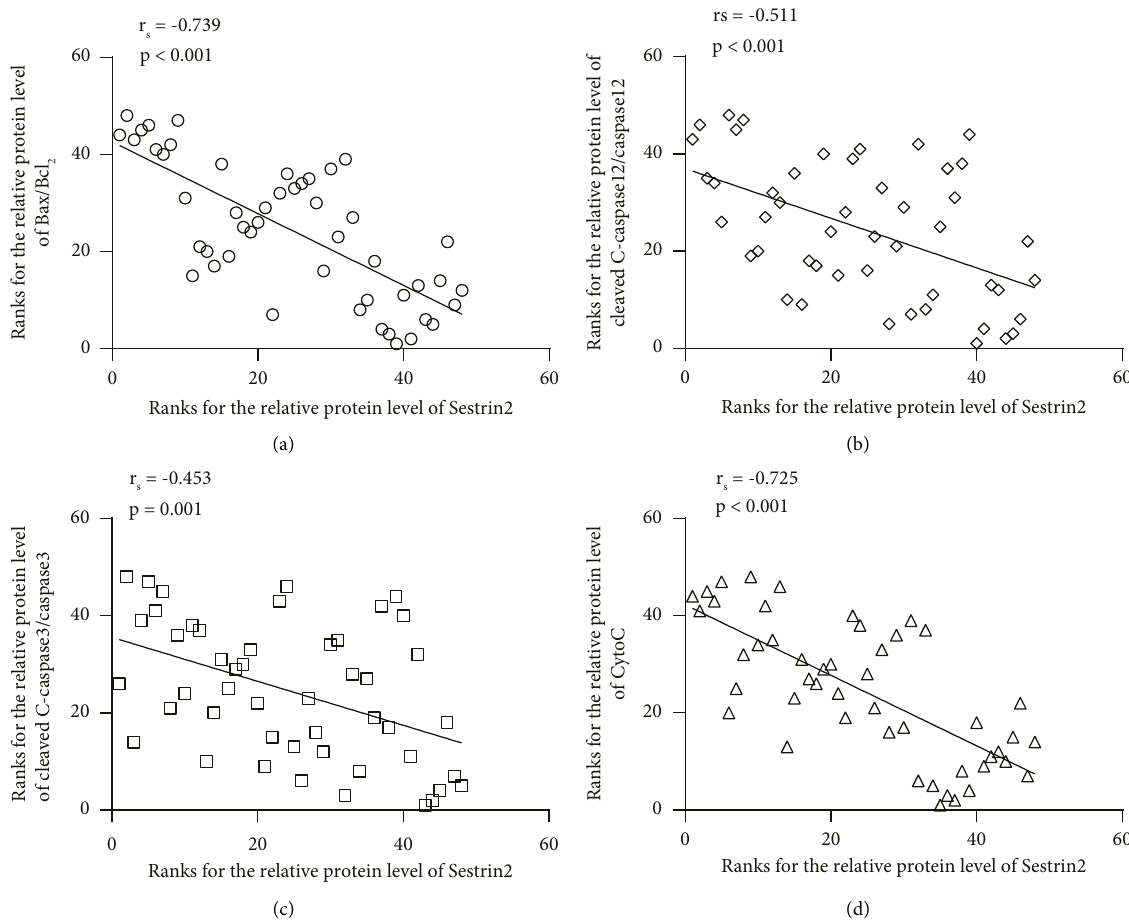
Figure 5: Te expression level of Sestrin2 was negatively correlated with that of apoptotic-related markers in HepG2 cells. Tis graphic plotted the rank correlation between the relative protein levels of Sestrin2 and (a) Bax/Bcl2 ( ρ � − 0.739, P < 0 . 001), (b) C-caspase12/ Caspase12 ( ρ �− 0.453, P � 0 . 001), (c) C-caspase3/Caspase3 ( ρ � − 0.511, P < 0 . 001) and (d) CytoC ( ρ �− 0.725, P < 0 . 001) in HepG2 cells in which the gene expression of Sestrin2 was manipulated to be either upregulated or down-regulated by plasmid transfection. Spearman’s two-tailed correlation analysis was used to compare the fold change data obtained from Western Blot densitometry analysis of indicated proteins. On the subplot, each point represents an individual sample of HepG2 cell culture ( n � 48 from 5 independent experiments), and no outlier was excluded from this study. Te solid line is the best ft through the data, with the respective Spearman’s correlation coefcient displayed as